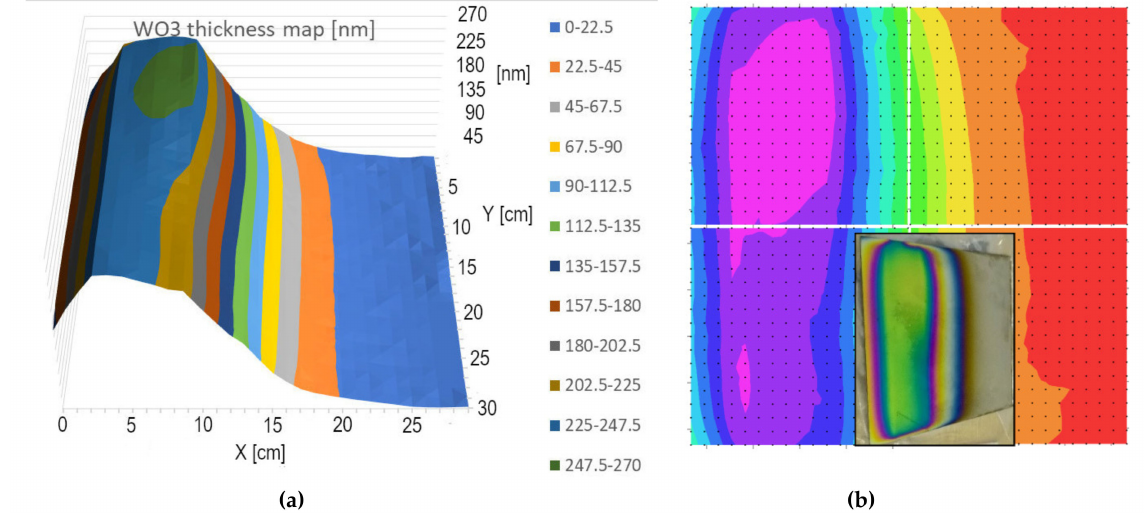
Figure 5. Thickness-maps (in nm) of a 30 × 30 cm sample. Maximum thickness value is 270 nm. One can compare ( a ) the results of expanded beam mapping and ( b ) the Woollam M2000 map. Notably, the M2000 map is compiled from four independently measured 15 × 15 cm parts. The photograph (inserted) shows the direct view of the sample.